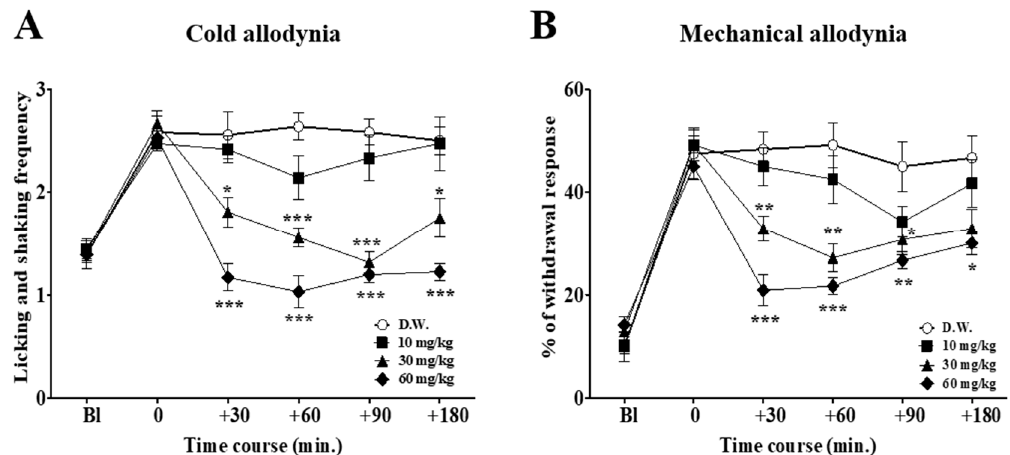
Figure 1. Time course of the effect of different doses of duloxetine on oxaliplatin-induced cold ( A ) and mechanical ( B ) allodynia in mice. Distilled water (D.W.) and three different doses of duloxetine (10, 30, and 60 mg/kg) were administered intraperitoneally ( n = 7/group). D.W. was injected to control group mice. On the timeline, Bl refers to the assessment made before the injection of oxaliplatin, and 0 refers to the assessment made three days after the oxaliplatin injection, just prior to the administration of duloxetine. Bl: baseline. Data is presented as the standard error of the mean ± (S.E.M.); * p < 0.05, ** p < 0.01, *** p < 0.001 vs. D.W.; by Bonferroni post-test after one-way ANOVA.